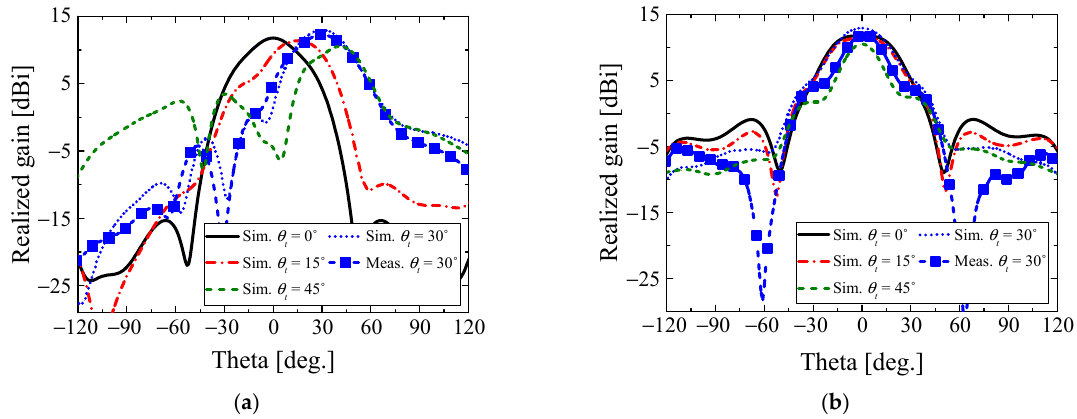
Figure 12. Radiation patterns for different target directions θ t = 0°, 15°, 30° and 45° on the ( a ) H-plane and ( b ) E-plane. All results are obtained at the design frequency. Table 2. Simulated performance parameters of the proposed antenna.